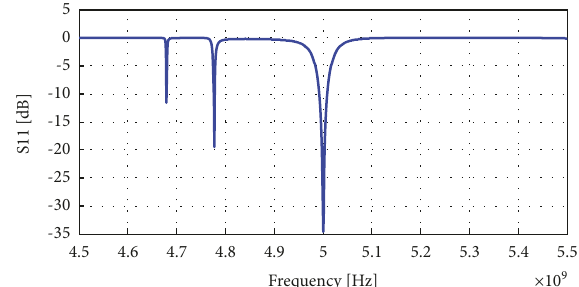
Figure 12: Return loss of the fractal antenna with loaded metamaterial structure.